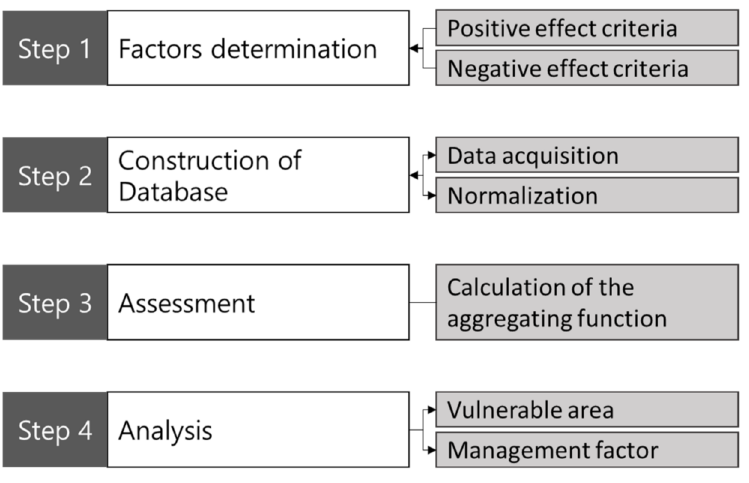
Figure 1. The study